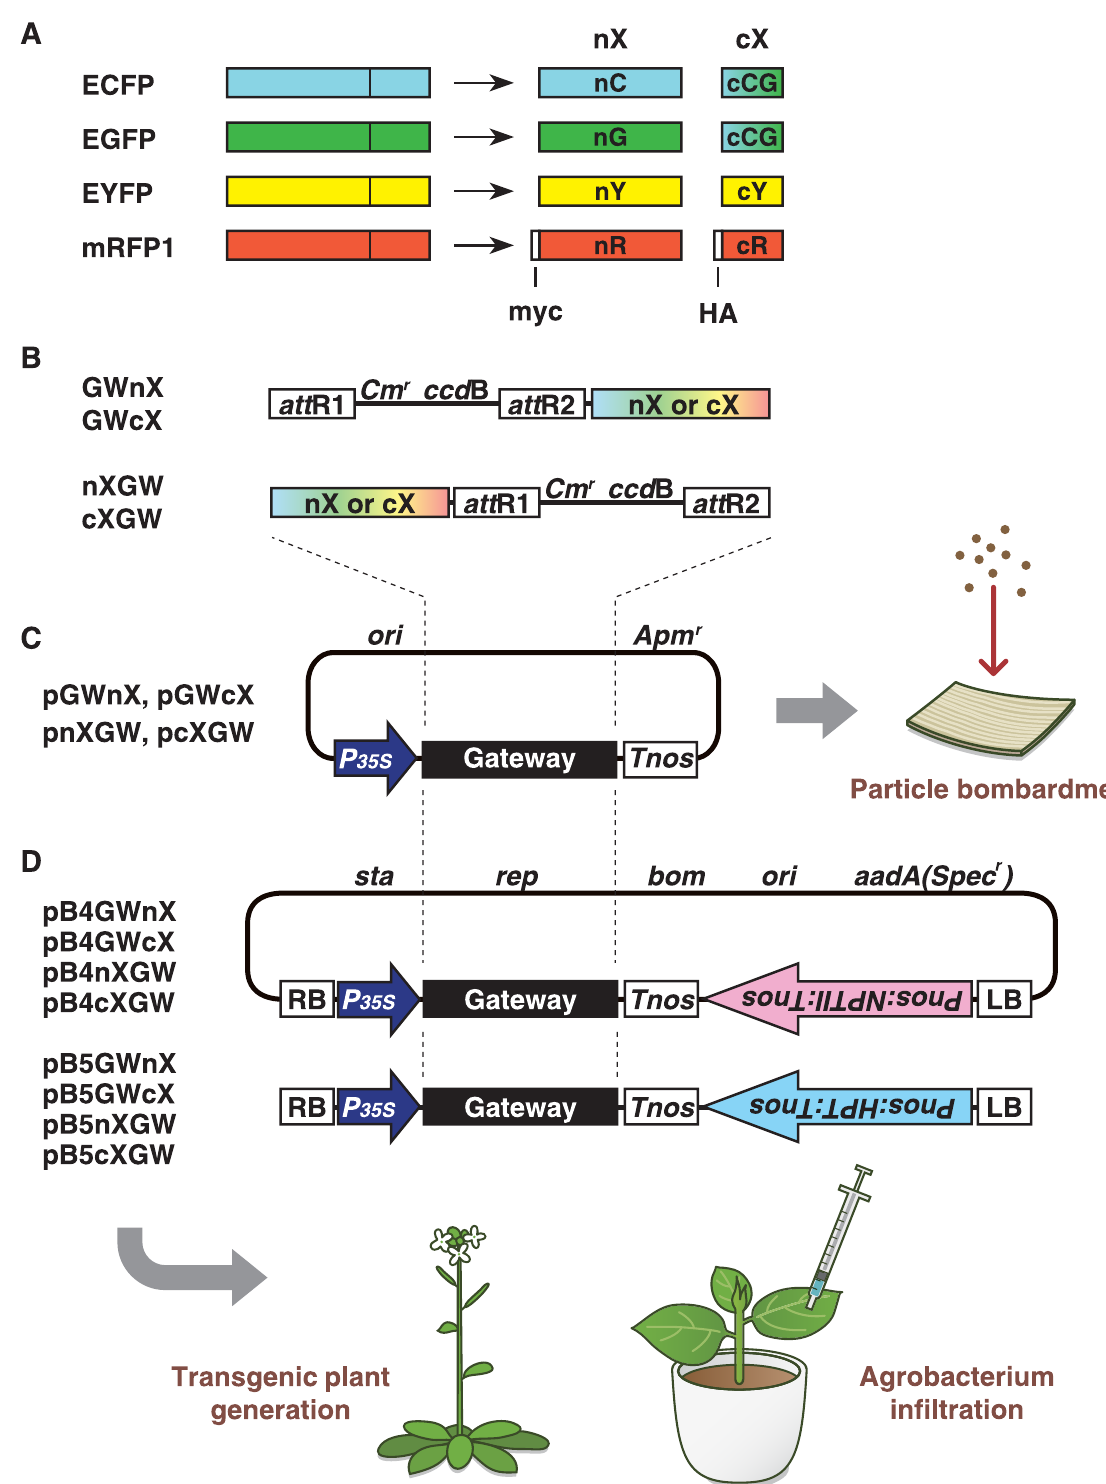
Fig 1. Schematic diagrams of the Gateway cloning technology-compatible vectors. A. ECFP, EGFP, EYFP and mRFP1 can be divided into two fragments. The letters ‘ n ’ and ‘ c ’ represent N- or C-terminal fragments of a split fluorescent protein, and the letters ‘ C ’ , ‘ G ’ , ‘ Y ’ and ‘ R ’ represent the type of fluorescent protein (ECFP, EGFP, EYFP or mRFP1). Since the nucleotide sequences of C-terminal CFP and C-terminal GFP are identical, we designated the fragment cCG. The letters ‘ myc ’ and ‘ HA ’ in the